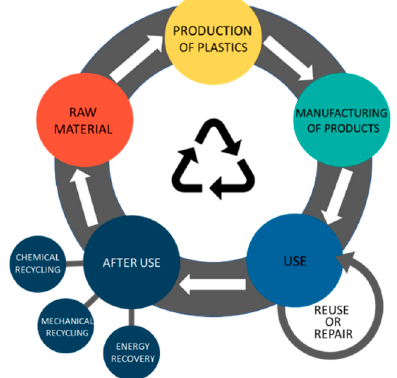
Figure 1. Recycling management concept.